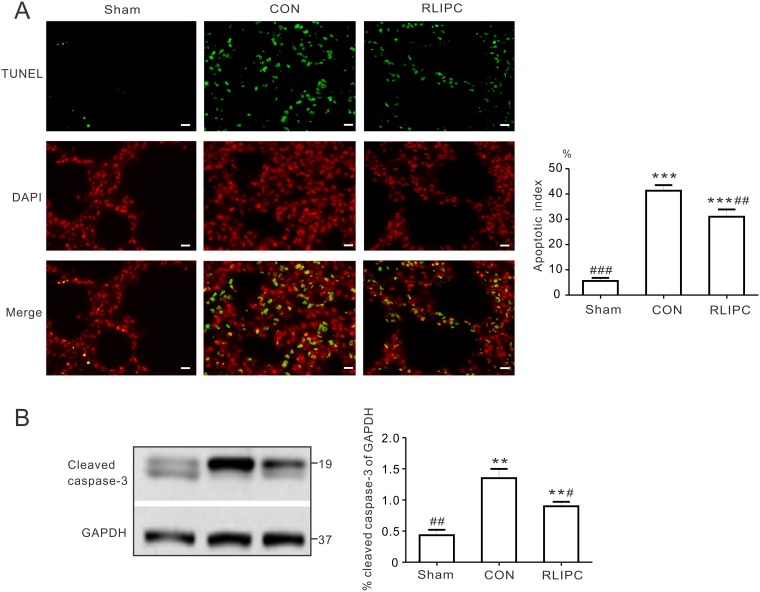
RLIPC reduces pulmonary apoptosis post I/R.A. Terminal transferase dUTP nick end labeling (TUNEL) technique was applied for the analysis of pulmonary apoptosis. Left, TUNEL-positive nuclei in the left lungs obtained from sham-operated (sham), liver conditioned (RLIPC) and control (CON) rats after pulmonary reperfusion injury were stained green (TUNEL) and nuclei were stained red (DAPI). Scale bars, 20μm. Right, Bar graph showing the TUNEL-positive nuclei expressed as a percentage of total nuclei in the left lung sections; n = 4–6. All data were expressed as mean ± SEM. ***P<0.001 compared with sham-operated lungs, ##P<0.01, ###P<0.001, compared with CON (by One-way ANOVA). B. Representative Western blots (left) and quantification (right) of cleaved caspase-3 protein band density (normalized to GAPDH) in sham, CON, and liver-conditioned rat left lungs are shown; n = 5. **P<0.05, compared with sham-operated rats; #P<0.05, ##P<0.01, compared with CON (by One-way ANOVA).